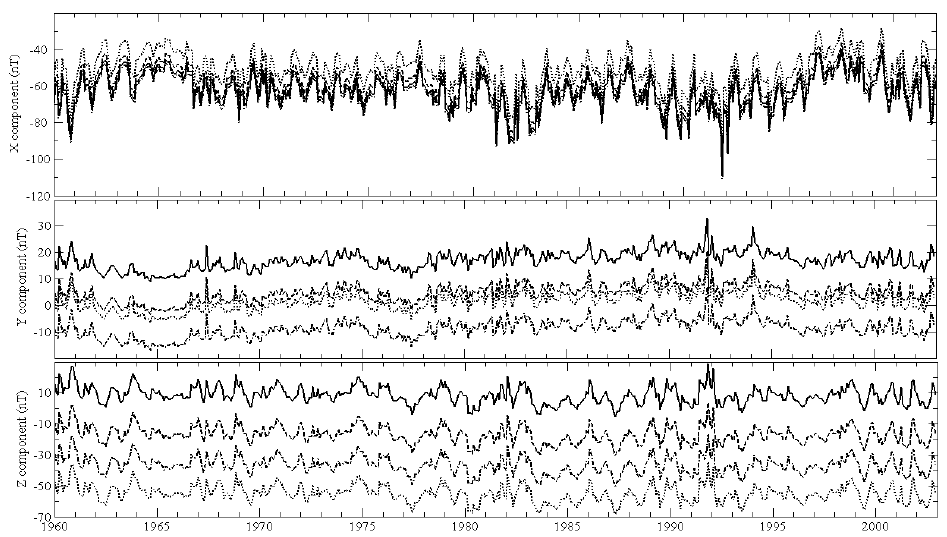
Figure 8. X, Y, Z - component differences between monthly mean values at NGK observatory and respective values predicted by CM4 model with maximum degrees L : a) 65 (solid line), b) 45 (dashed line), c) 35 (dash-dotted line), d) 25 (dotted